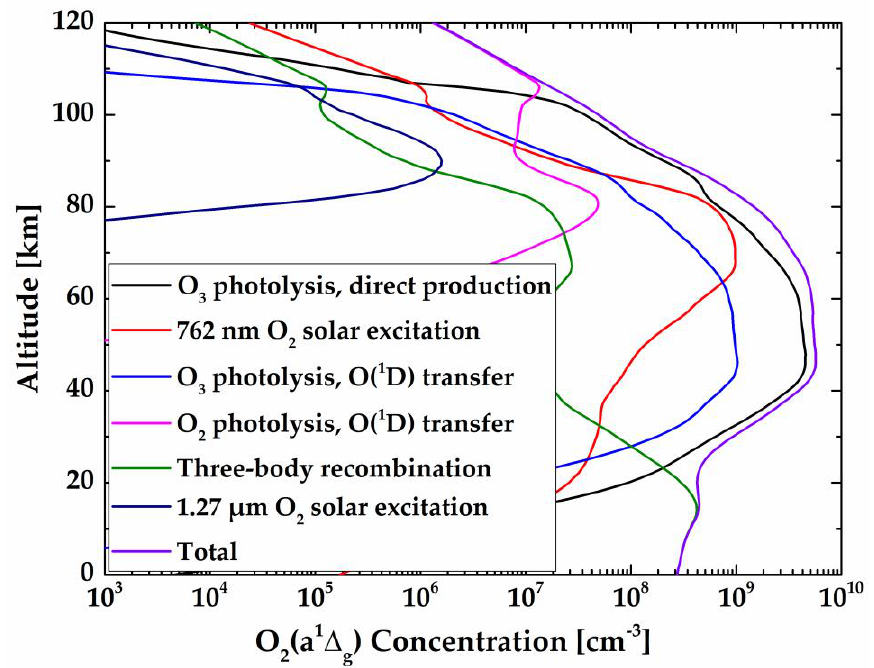
Figure 3. The modeled O 2 (a 1 Δ g ) concentration profile and respective contributions of each production mechanism.